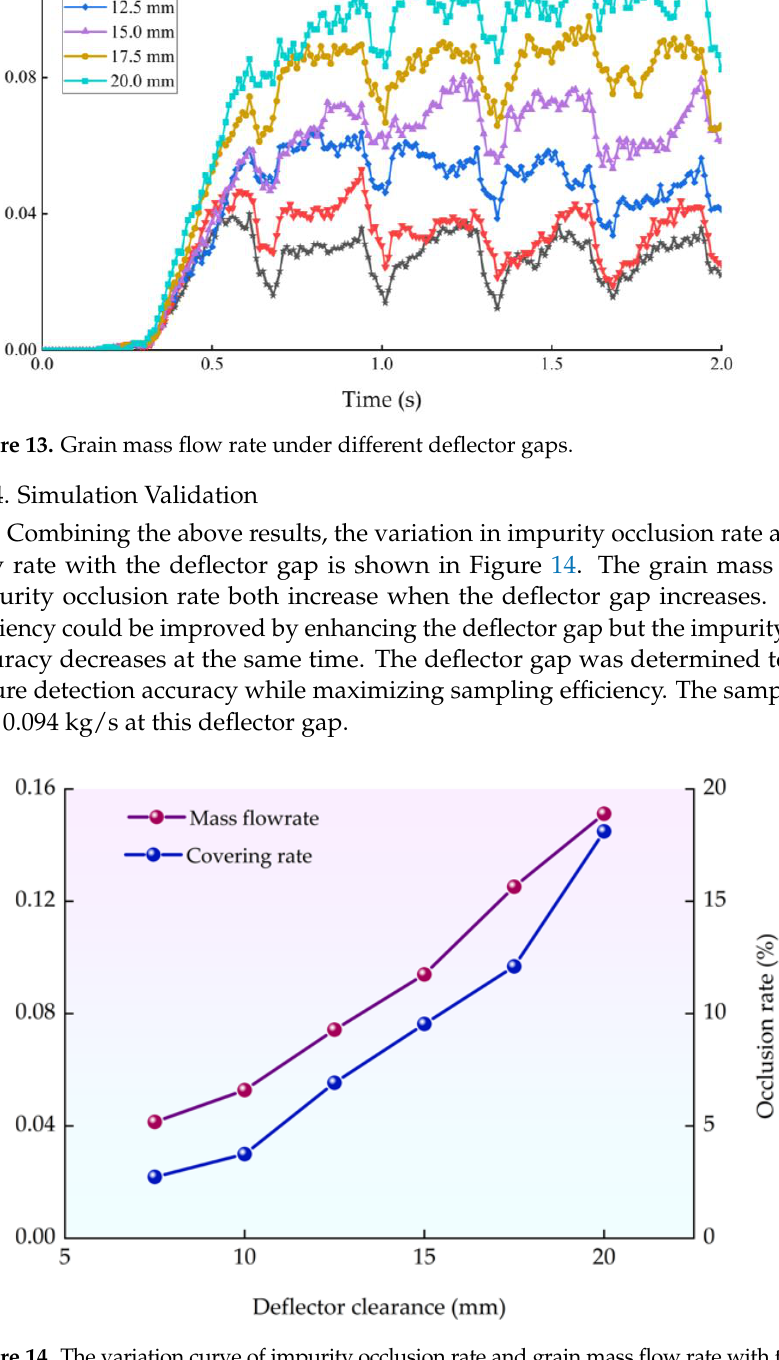
( f ) Figure 12. Grain distribution analysis under different deflector gap. ( a ) d = 7.5 mm; ( b ) d = 10 mm; ( c ) d = 12.5 mm; ( d ) d = 15 mm; ( e ) d = 17.5 mm; ( f ) d = 20 mm. 3.2.3. Effect on the Grain Mass Flow Rate